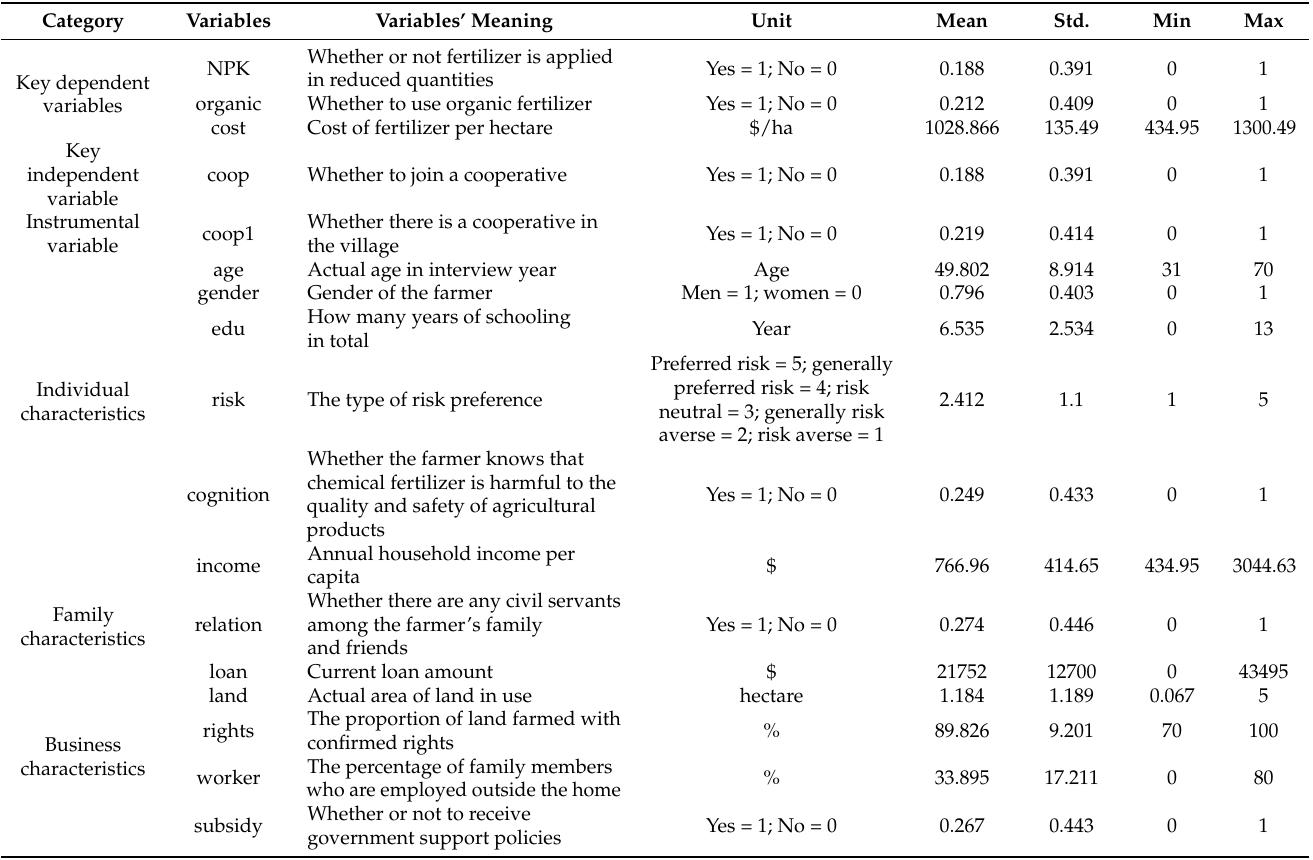
Table 1. Variable definitions and summary